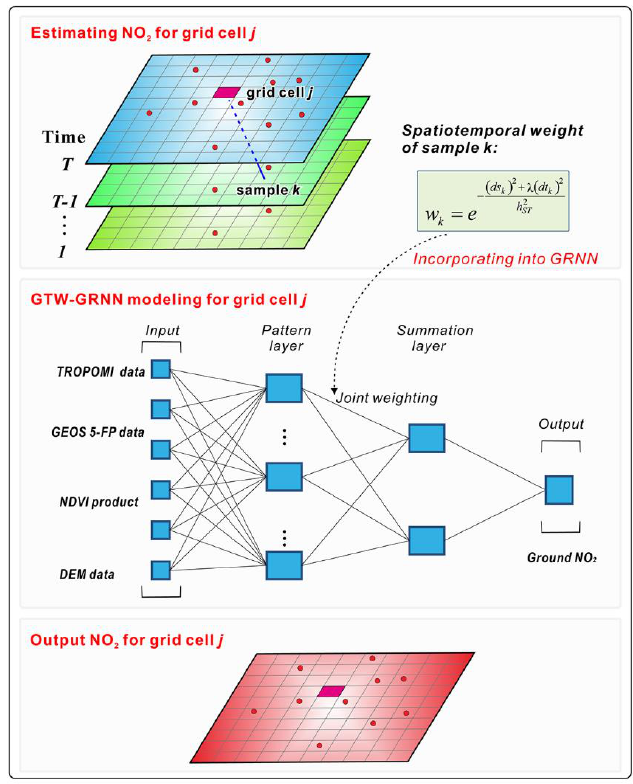
Figure 2. GTW-GRNN model for estimating ground-level NO 2 .